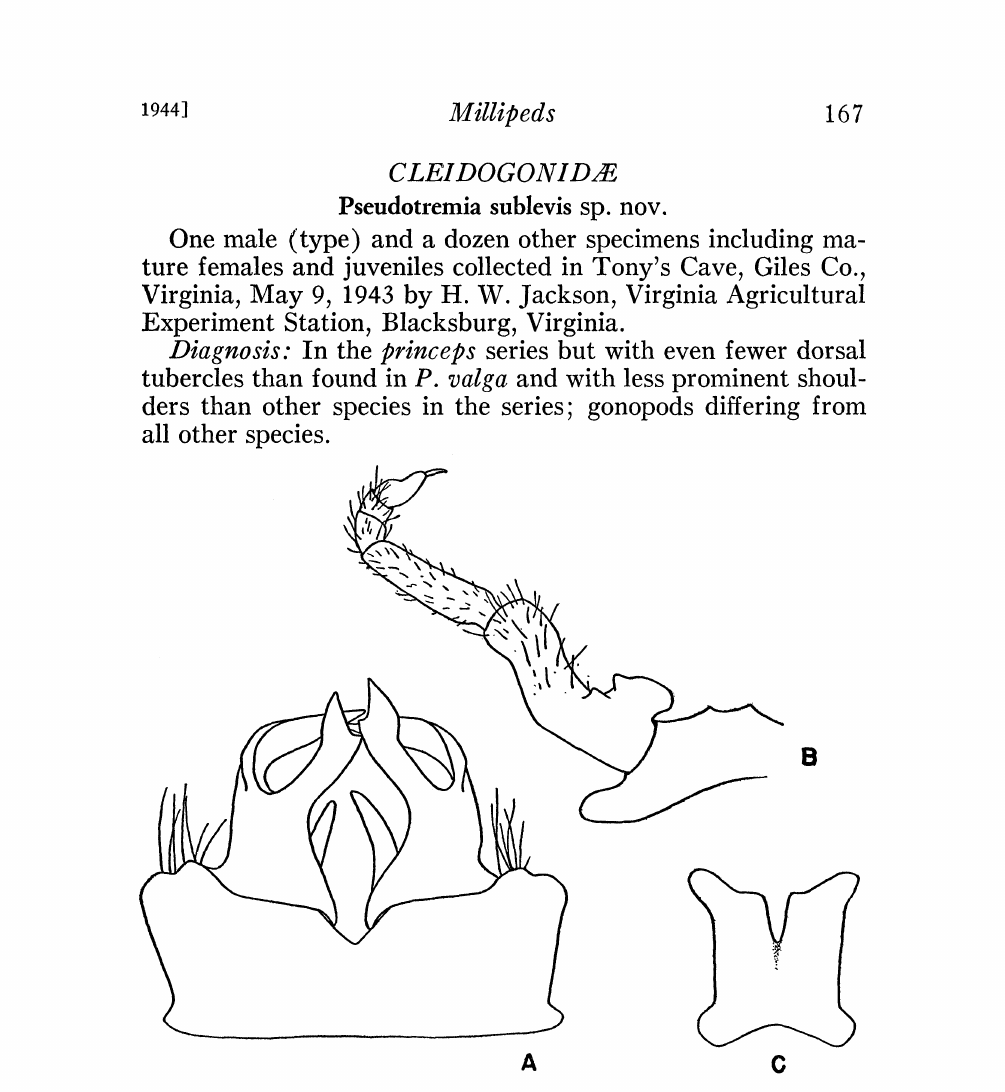
Fig. 1. Pseudotremia sublevis, a, Gonopods; b, Ninth leg; c, Bifid laminae. Description: Size large, exceeded only by princeps, maximum length 30 mm.; body cylindrical, not rapidly reduced in width at either end, the females even less fusiform than the males with body widest at about segment 9 or 10; color slate blue-